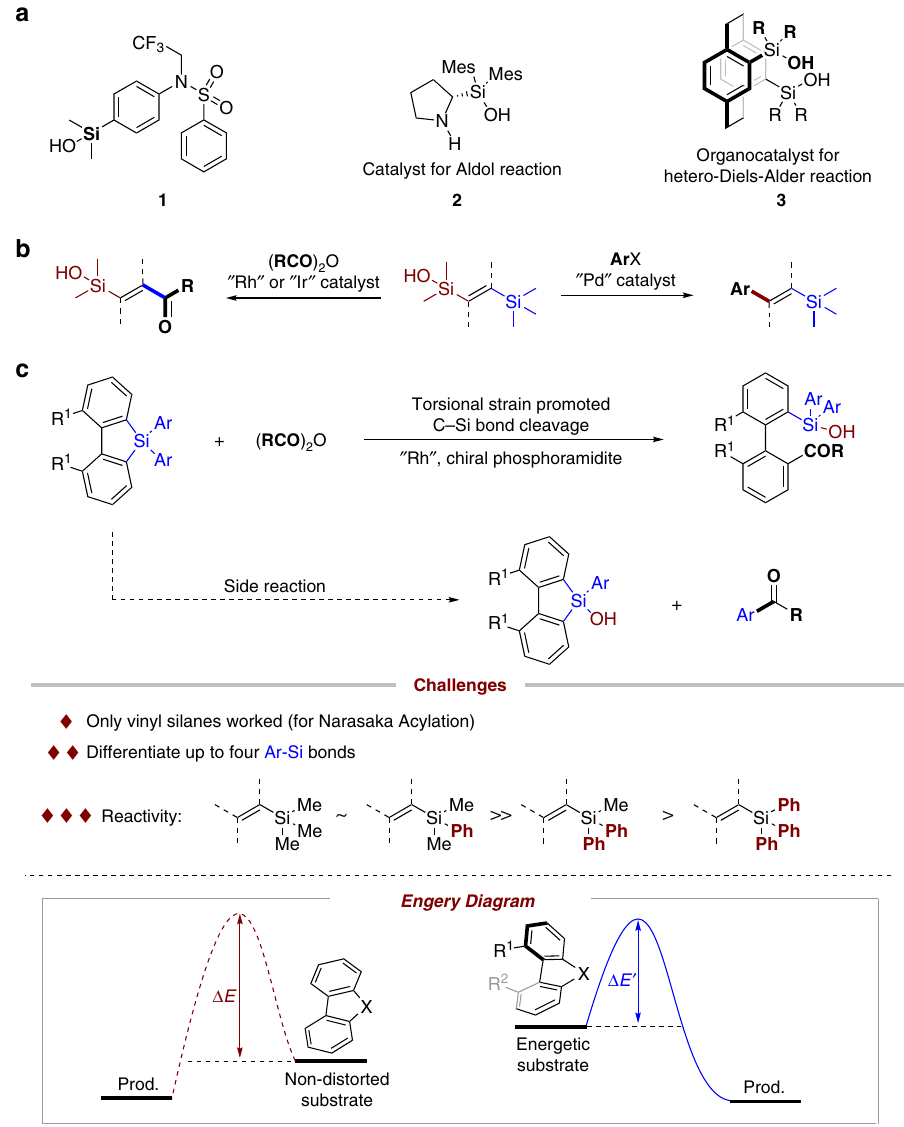
Fig. 2 Carbon – silica bond cleavage for atropisomer synthesis. a Silanols in drug scaffold or ligands. b Narasaka acylation and Hiyama coupling. c Asymmetric Narasaka acylation for atropisomer